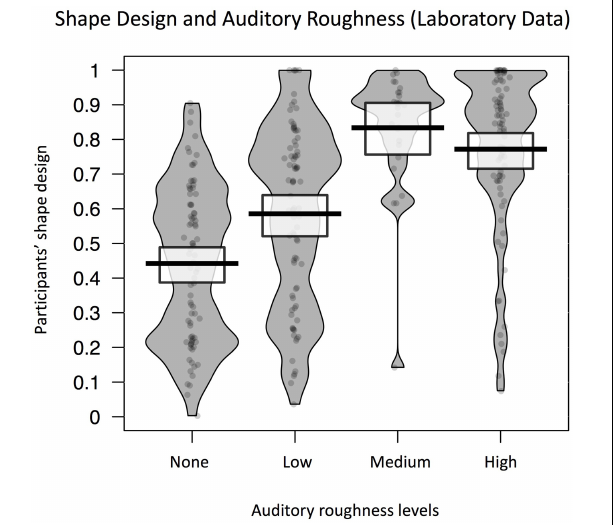
FIGURE 4 | Pirateplot showing overall pattern of individual shape design in Experiment 2 (solo lab setting), shown separately for different roughness levels. Shape design is significantly predicted by auditory roughness. The grey shaded area represents the distribution of participants’ shape design for each level of roughness, and the average lines and white boxes represent means and 95% highest density intervals